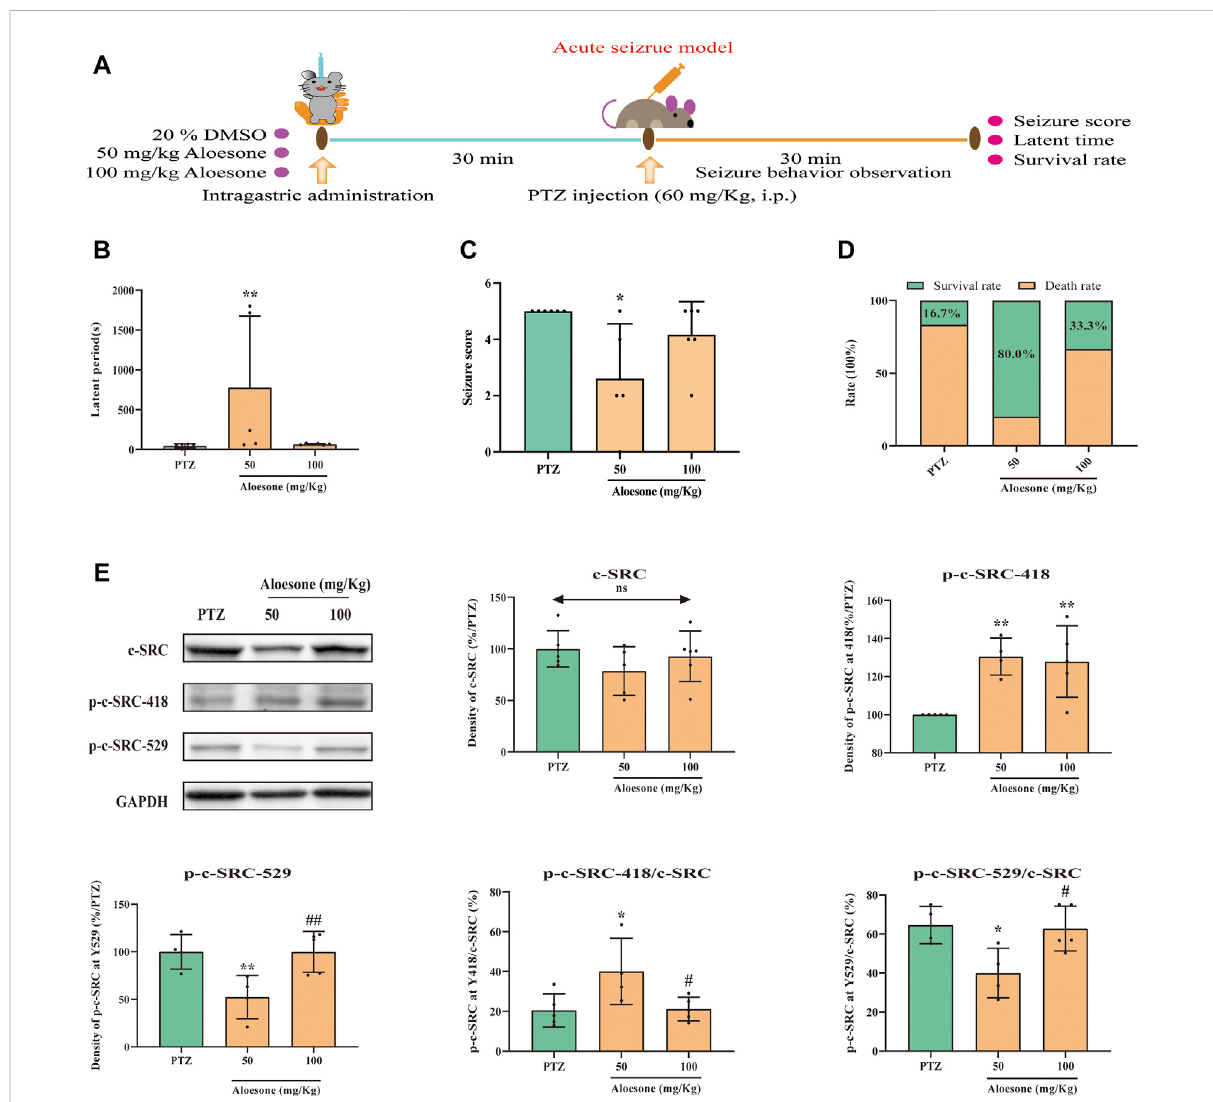
FIGURE 4 Effects of aloesone(50 and 100 mg/kg) on PTZ-induced acute seizures. (A) Procedureof inducing acute seizures with PTZ. (B) Latent period of PTZ-induced rats administered 20% DMSO only or aloesone (50 or 100 mg/kg). (C) Seizure score. (D) Survival and death rates. (E) Western